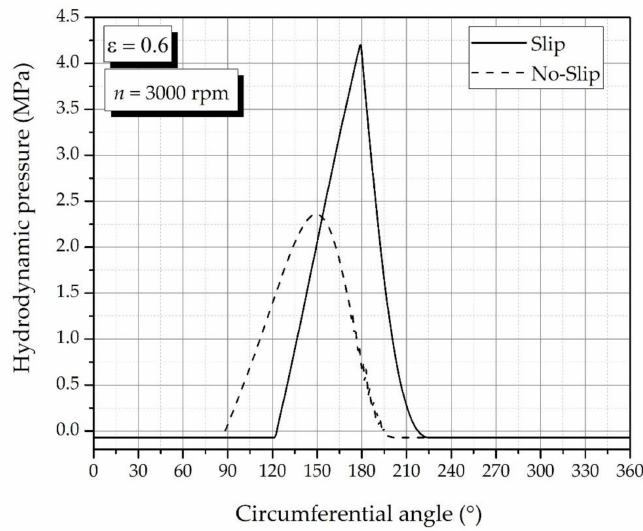
Figure 6. Comparison of the profile of hydrodynamic pressure between the conventional (no-slip) bearing and the heterogeneous slip/no-slip bearing. All results are evaluated at z / L = 0.5 and n = 3000 rpm.